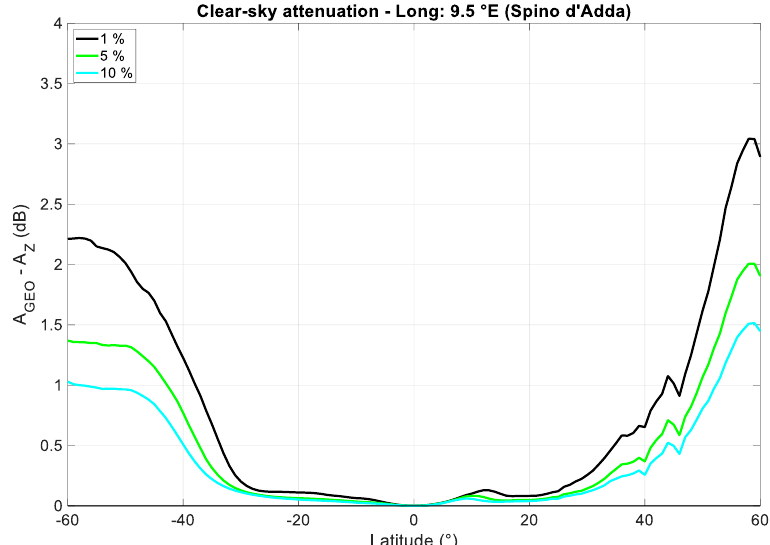
Figure 13. The difference A GEO − A Z , calculated at annual probabilities 1%, 5%, and 10%, between the clear-sky attenuation exceeded in the GEO path (elevation angle 37.7 ◦ ), A GEO , and that exceeded in the GeoSurf path, A Z , along the meridian of Spino d’Adda (9.5 ◦ ), in the latitude range 60 ◦ N to 60 ◦ S.